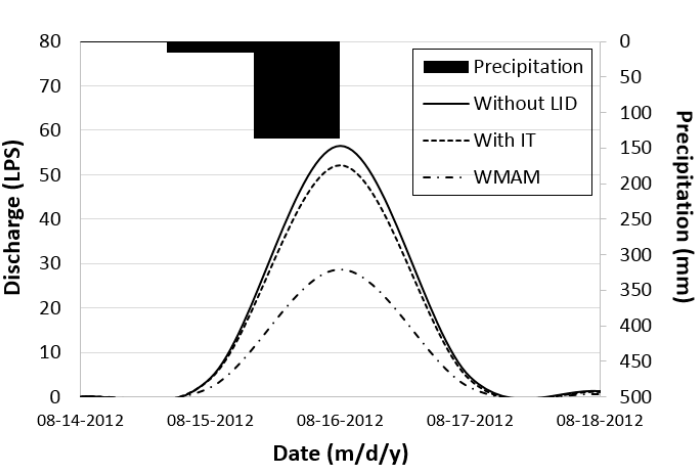
Figure 6. Hydrographs of subcatchment S5 using high-intensity rainfall data.